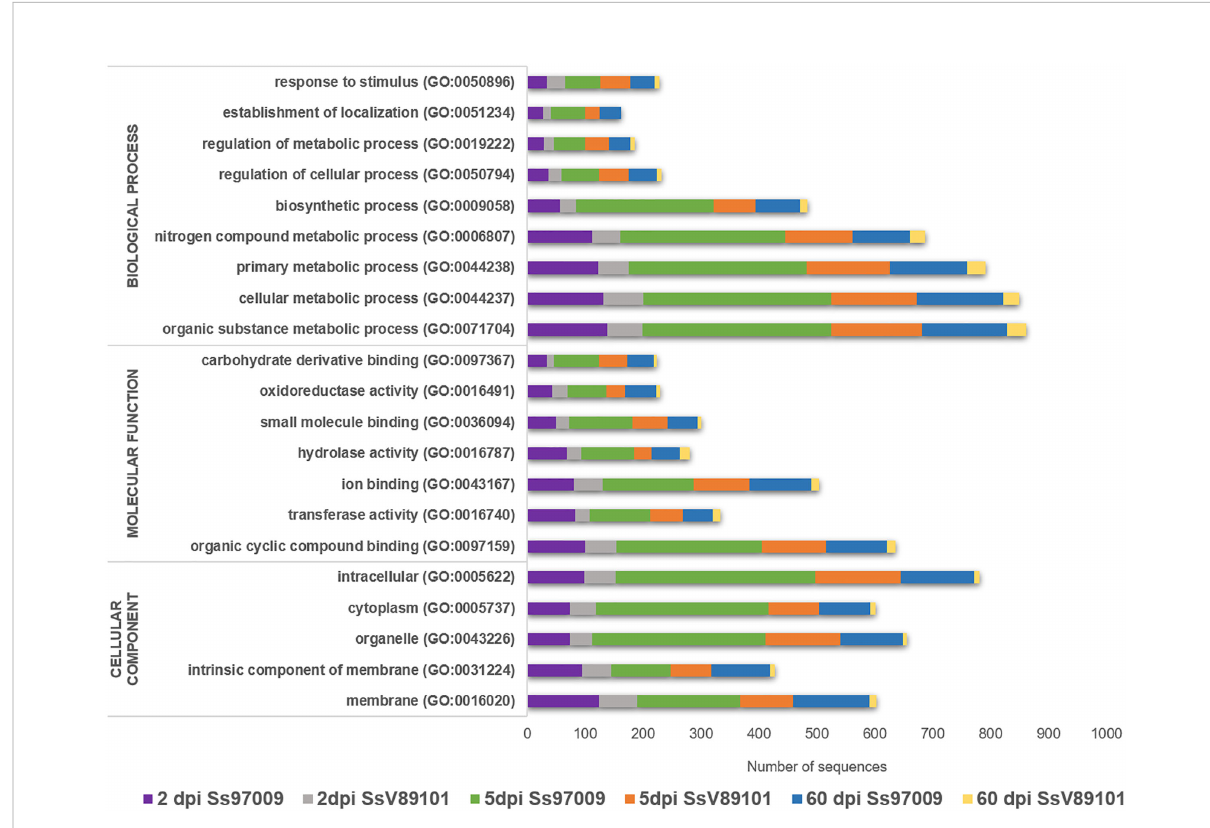
FIGURE 2 Gene ontology (GO) annotation of differentially expressed genes. The x-axis represents the number of sequences and the y-axis represents the GO terms under the main categories; biological process, molecular function, and cellular